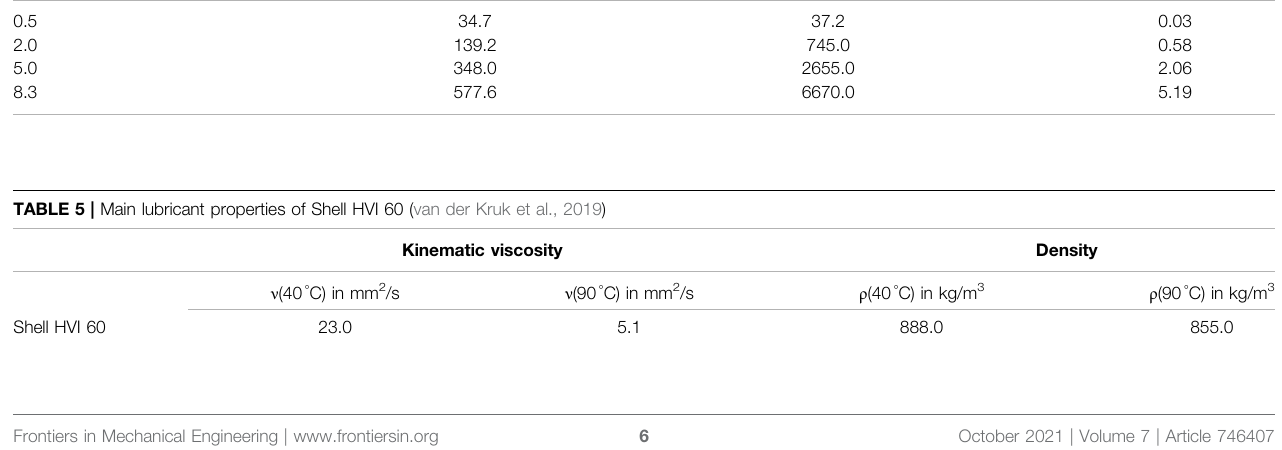
TABLE4| Toothmeshingfrequencyofpinionf z1 ,dropletfrequencyf DoD andresultingmeaninjection fl owrate _ V Oil asafunctionofcircumferentialspeedv t atthegeartestrig. Circumferential speed v t in m/s